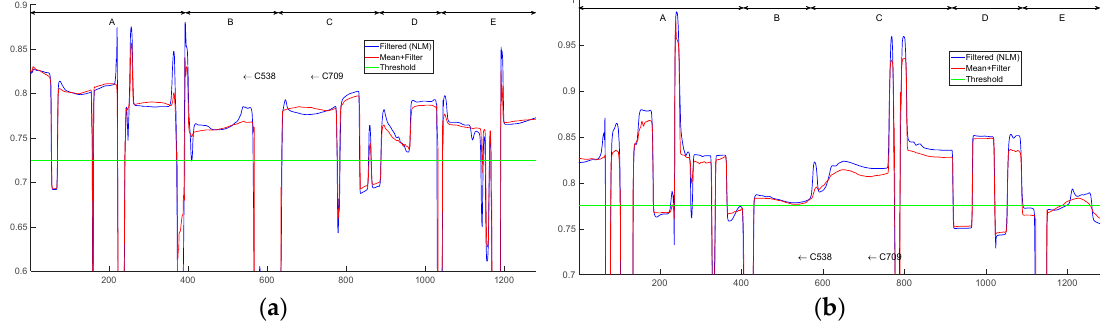
Figure 12. Thresholding: ( a ) line segment for R38; ( b ) line segment for R904.